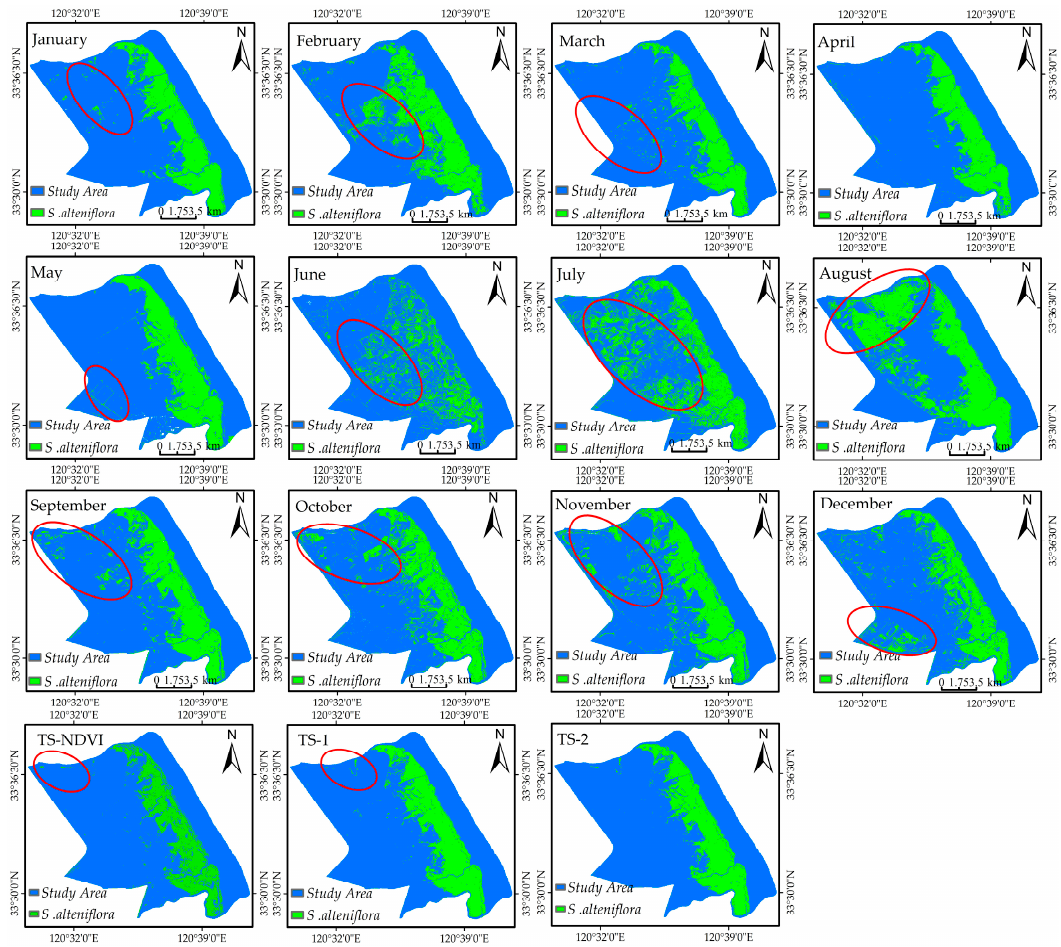
Figure A2. Classification map of S. alterniflora based on BSVM under the 15 schemes in Pattern 1 (January–December). The red circle shows the misclassification errors.